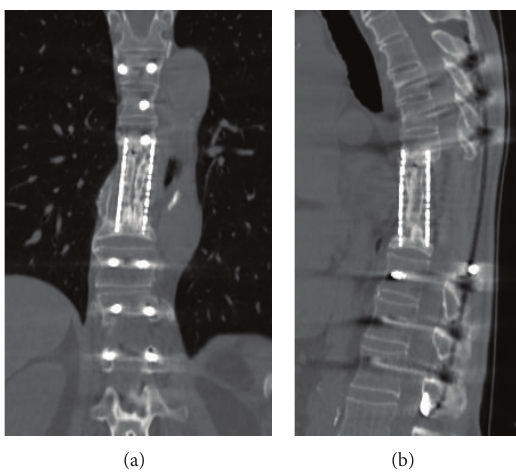
Figure 6: CT scans at 20 months after operation showing bone union. (a) Coronal, (b)